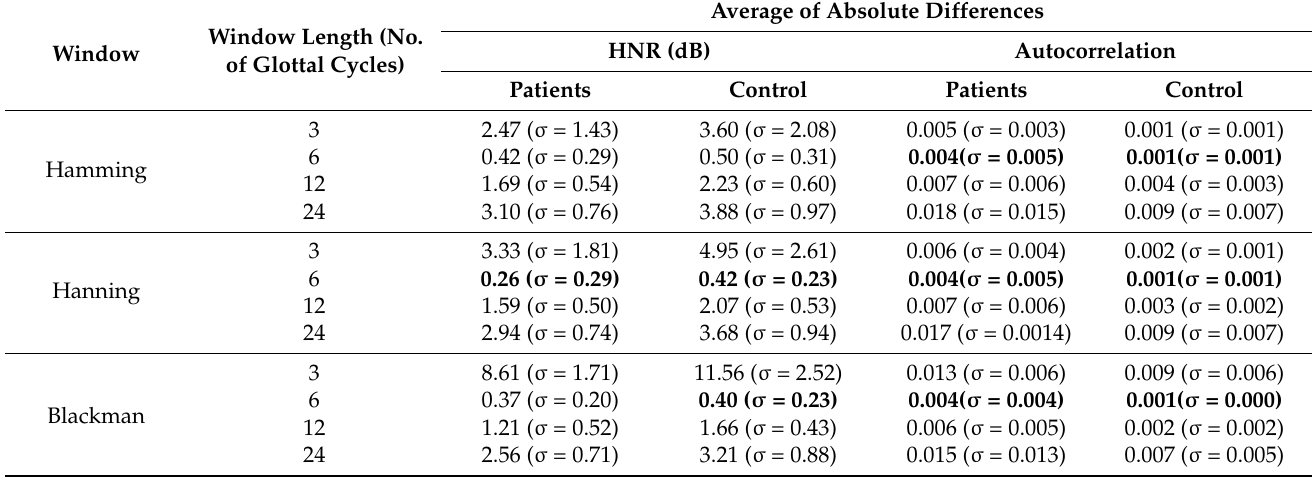
Table 1. Comparison of results from Praat and the proposed algorithm: HNR and Autocorrelation average differences and standard deviation for each window and length.